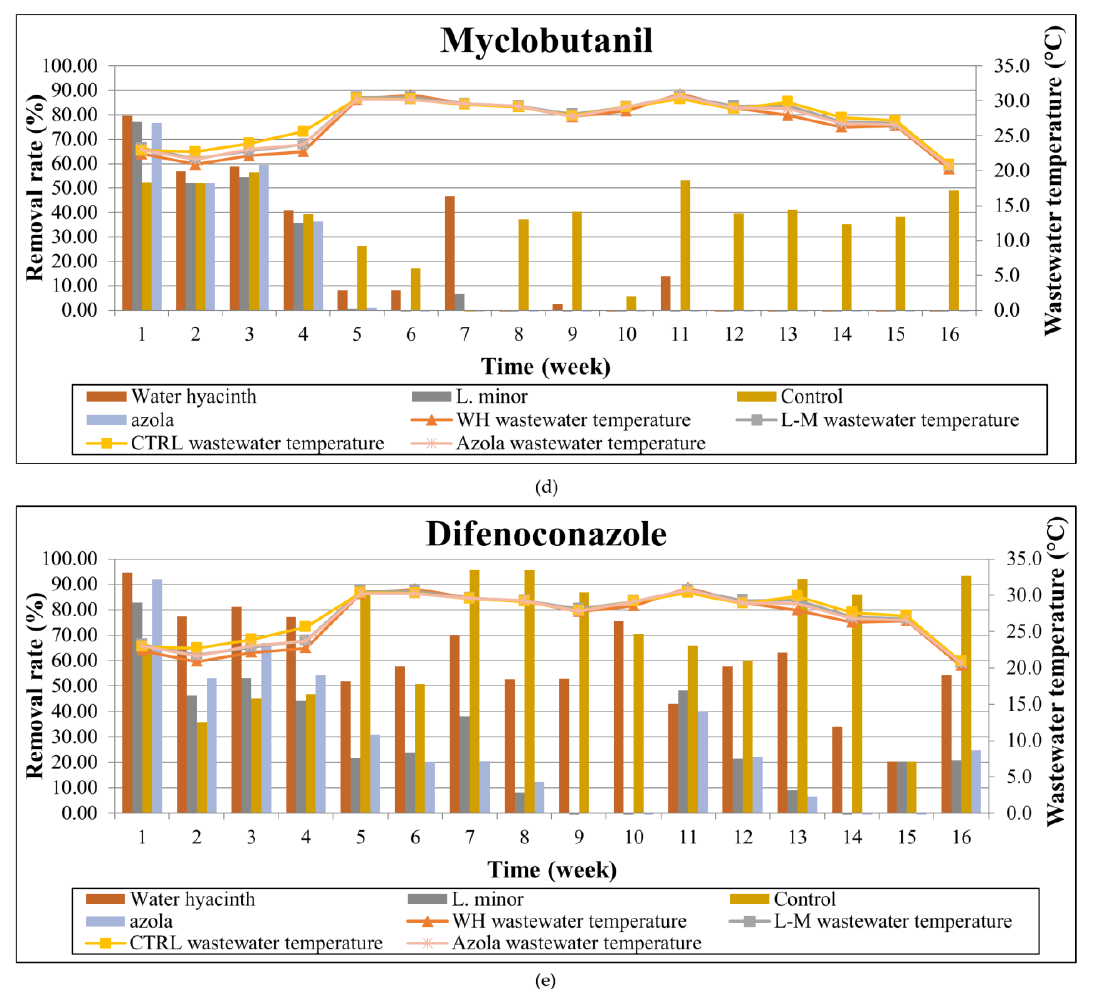
Figure 8. Temporal variation of removal rate per examined tank and wastewater temperature for: ( a ) Imidacloprid, ( b ) Thiacloprid, ( c ) Dimethomorph, ( d ) Myclobutanil, and ( e ) Difenoconazole.